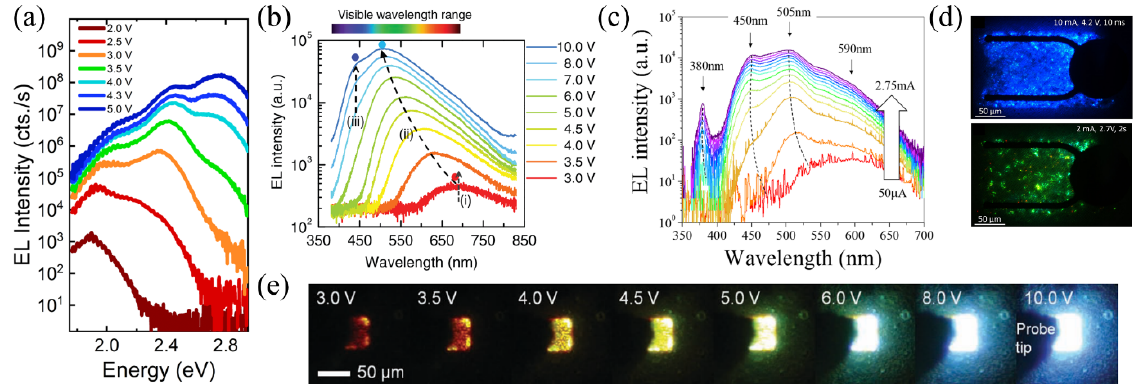
Figure 4. ( a ) EL spectra of a microrod LED with ITO as current spreading layer at different voltages